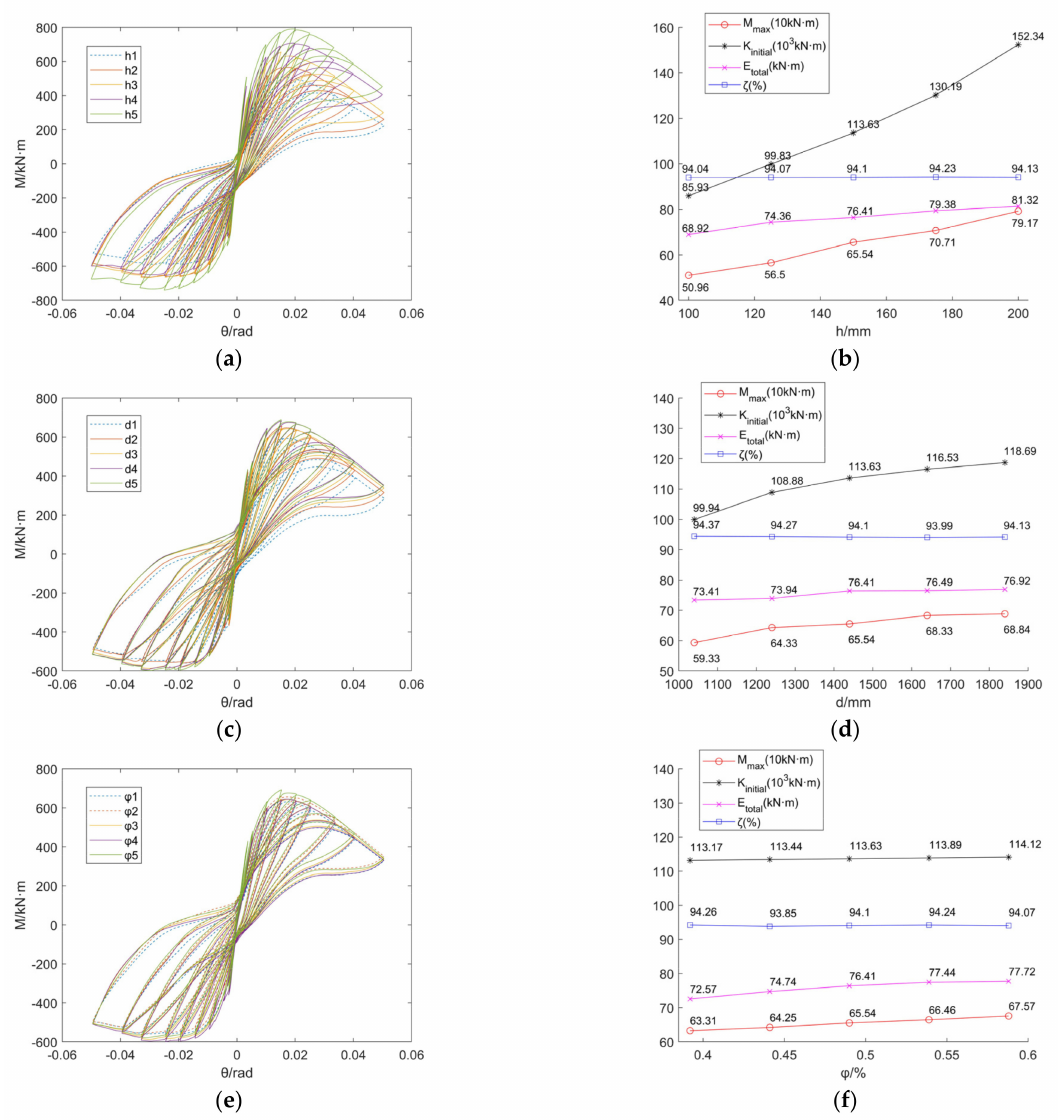
Figure 11. Results of parametric analysis: ( a ) hysteresis curves of slab thickness analysis; ( b ) line chart of slab thickness parameter analysis; ( c ) hysteresis curves of slab width analysis; ( d ) line chart of slab width parameter analysis; ( e ) hysteresis curves of slab reinforcement ratio analysis; ( f ) line chart of slab reinforcement ratio parameter